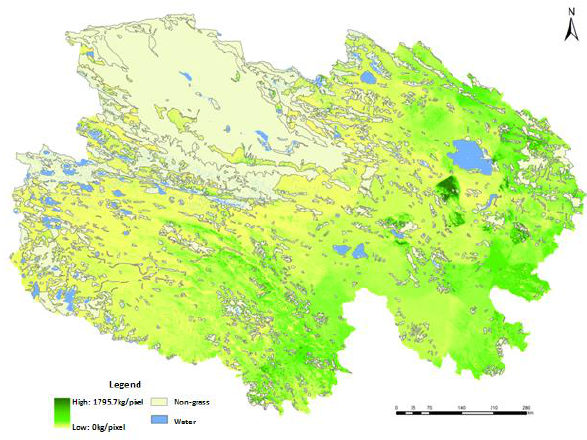
Figure 4. The grass yield map of QingHai Province in